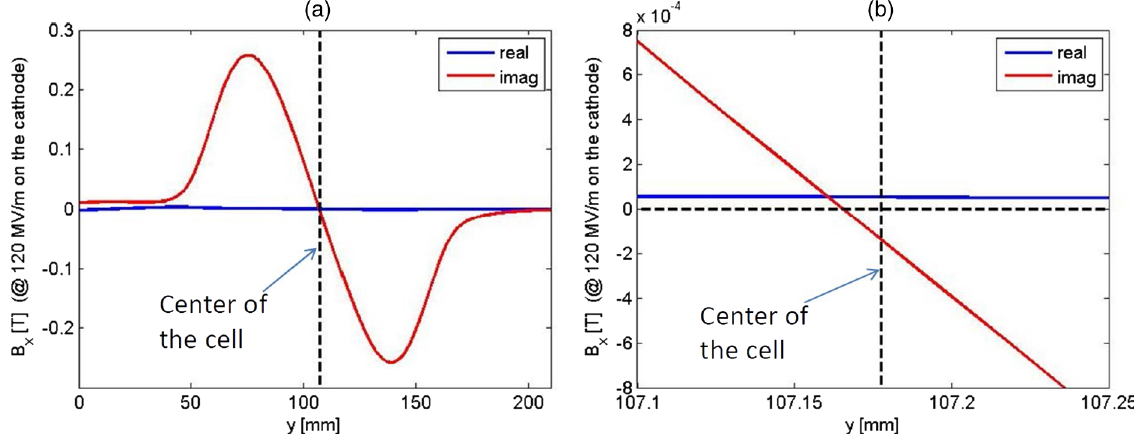
FIG. 30. Transverse magnetic field calculated along line 1: (a) y ¼ 0 is the input waveguide; (b) enlargement of the central region of the cell.